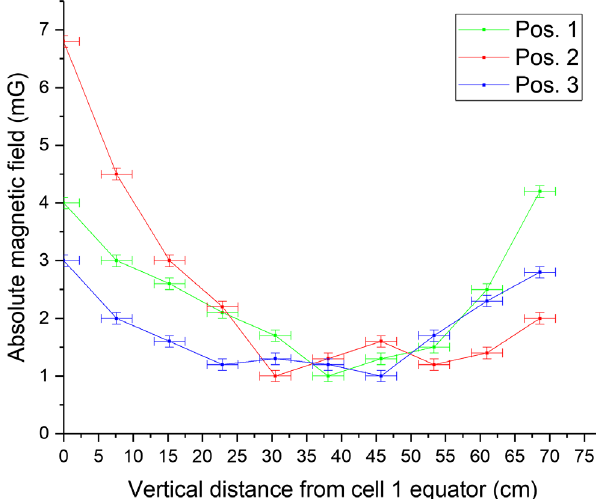
FIG. 4. Background magnetic field in the vertical test dewar. The fields were measured by lowering fluxgate magnetostatic sensors in increments to create a vertical scan at three different horizontal positions. The sensor locations were offset from the center axis by the same distance as the cavity equator, and they are spaced by 120° in the azimuthal direction from each other. These were measured with the cavity installed in the dewar together with the dewar lid; however, this measurement could only be conducted at room temperature, not at 2K.